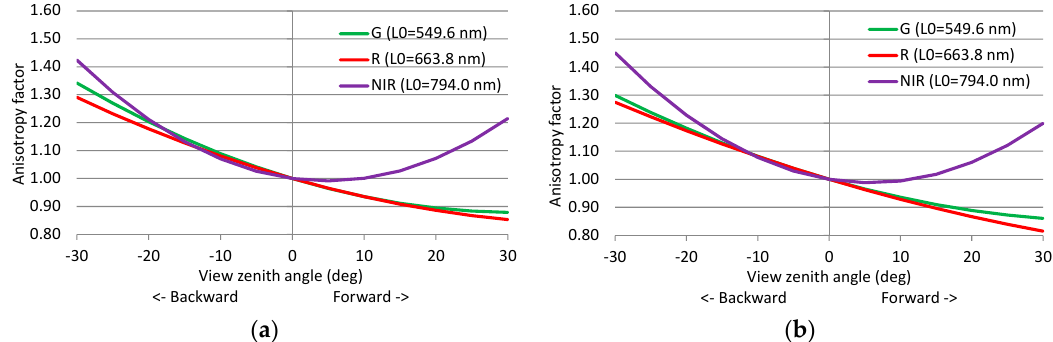
Figure 14. Anisotropy factors for green (L0 = 549.6 nm), red (L0 = 663.8 nm) and NIR (L0 = 794.0 nm) bands in the solar principal plane for ( a ) the full dataset and ( b ) flight f34 with sun zenith angle of 39.8°.